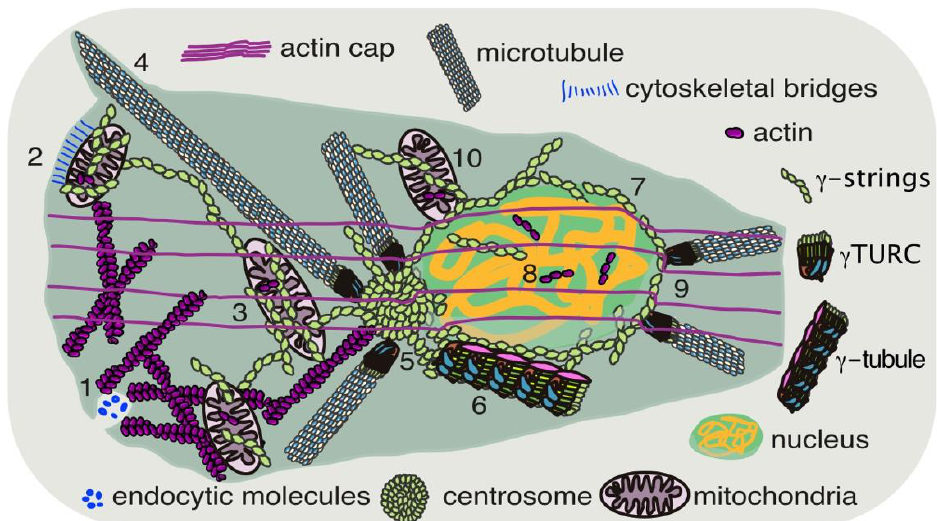
Figure 1. Actin, microtubules and the γ -tubulin meshwork hub cellular signals and